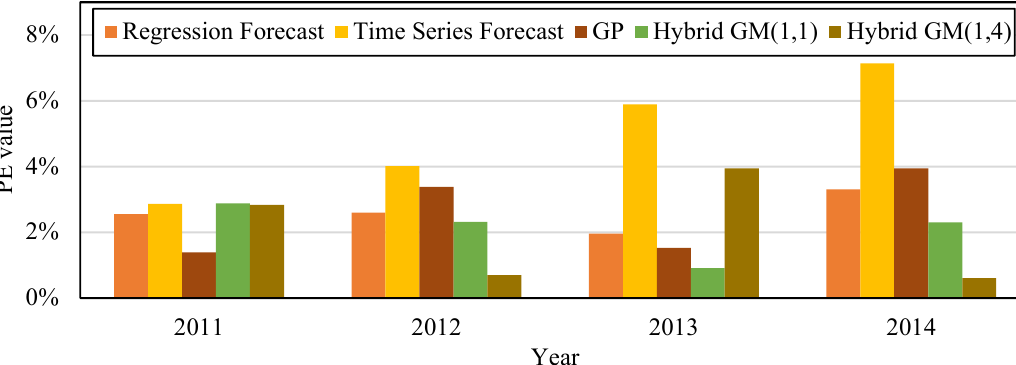
Figure 7. Comparison of PE values of the five forecast models trained with the data from 2011–2013 and tested with the data in 2014.